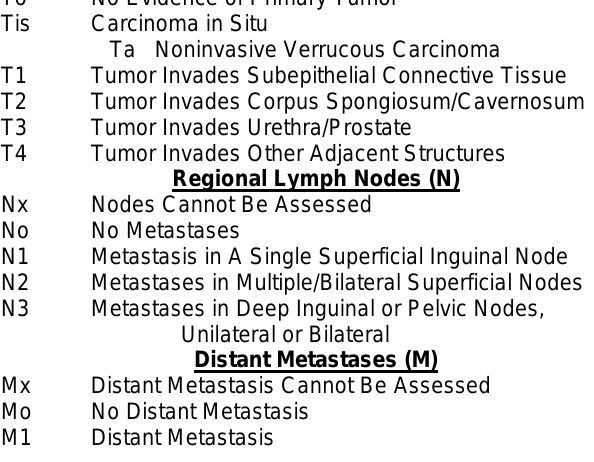
TNM Staging of Penile